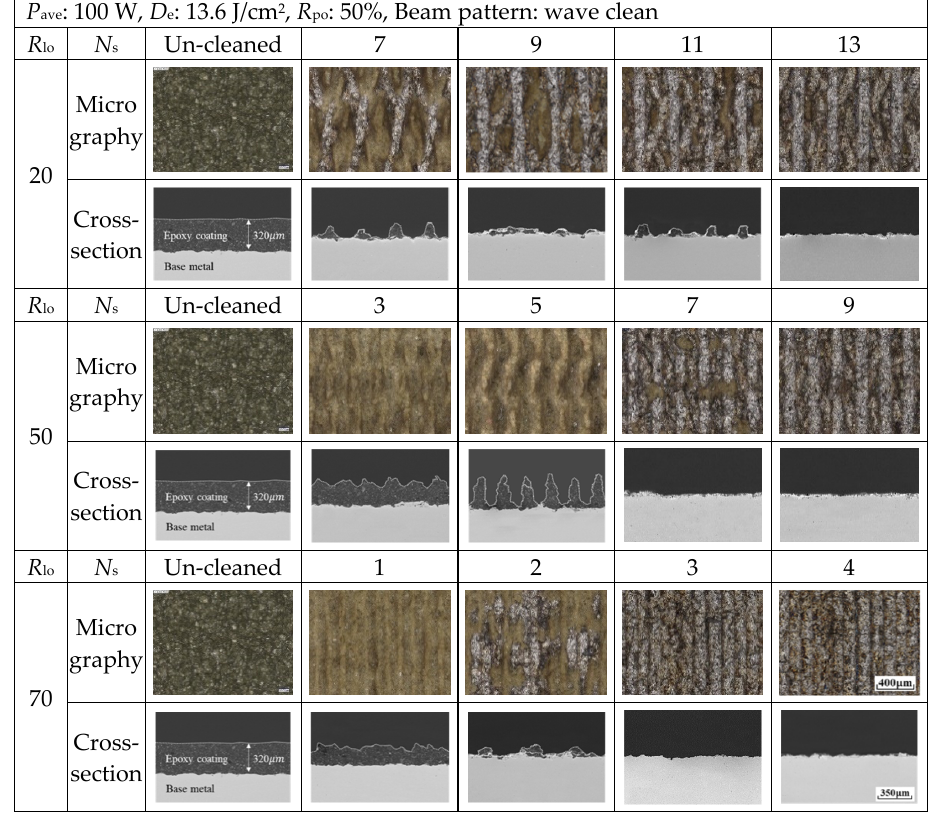
Figure 9. Micrography and cross-section of the laser-cleaned surfaces at a pulse overlap rate of 50%.